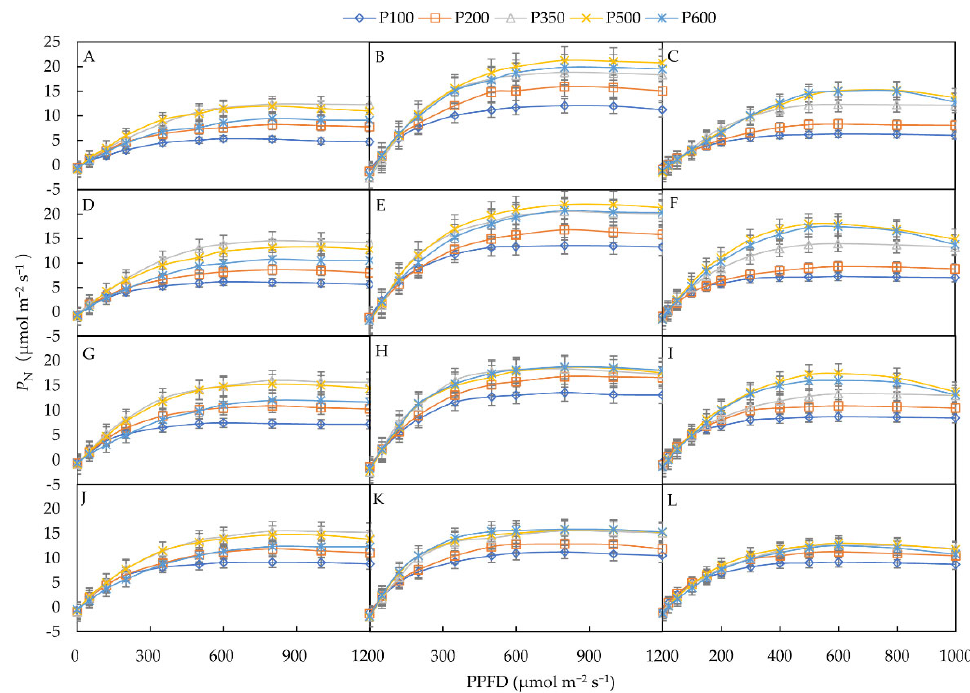
Figure 1. The light–response curves at different light intensity and temperature treatments at week 2 ( A – C ), 3 ( D – F ), 4 ( G – I ), and 5 ( J – L ) after transplanting. P N —net photosynthetic rate. Left side ( A , D , G , J ), middle ( B , E , H , K ), and right side ( C , F , I , L ) represented T15, T23, and T30, respectively. Mean values with standard error of mean ( n = 3). Table 1. The analysis of variance for the effects of light, temperature, and their interactions on ap ‐